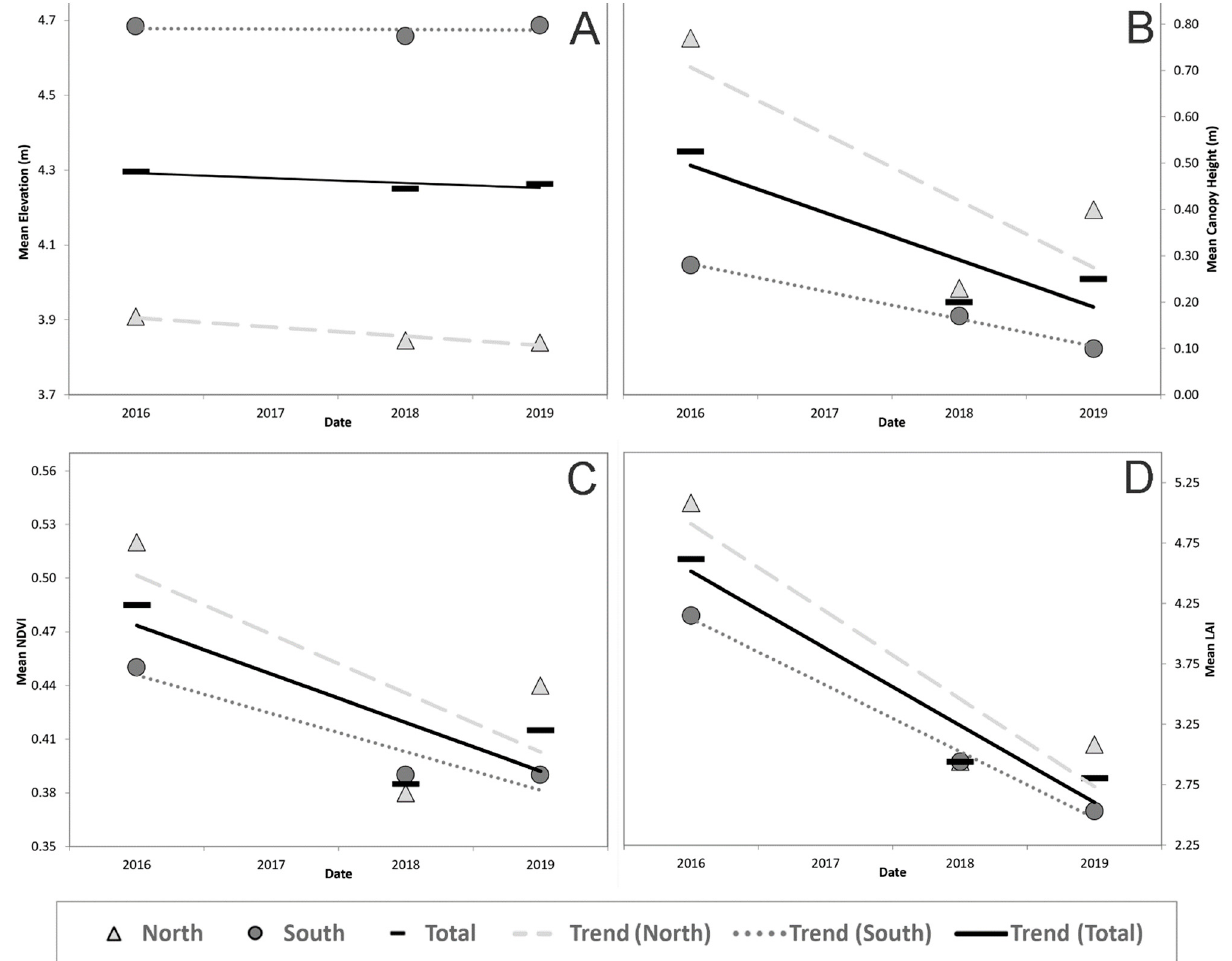
Figure 3. Means and trends of digital elevation model ( A ), canopy height model ( B ), normalized difference vegetation index ( C ), and leaf area index ( D ) within Pea Island assessment units from 2016 to 2019.